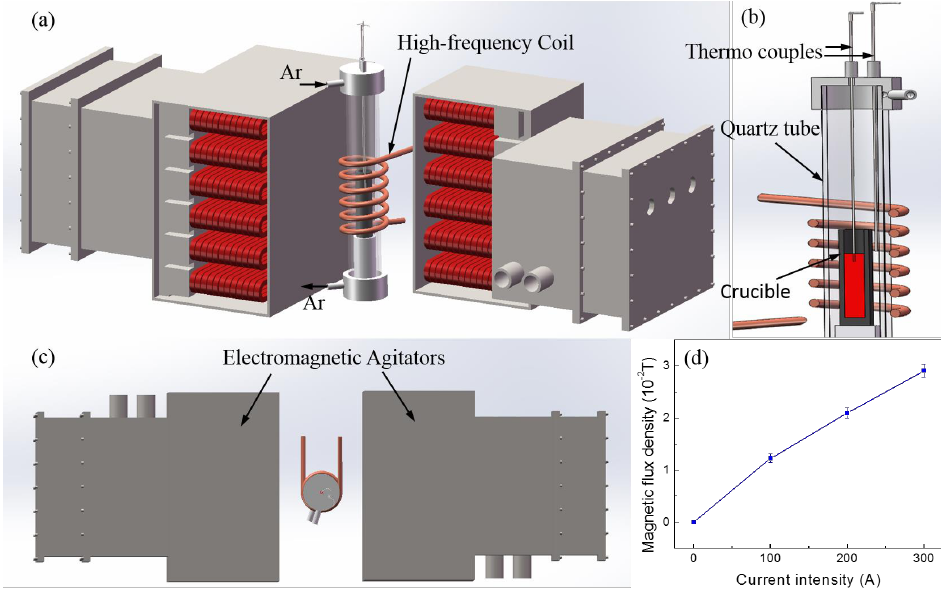
Figure 1. Schematic diagram of the experimental set-up for solidifying Cu-15%Co alloy with electromagnetic stirring (EMS): ( a ) Stereoscopic view; ( b ) Cutaway view of the smelting part; ( c ) Plan view; ( d ) The max magnetic flux density changes with current intensity.